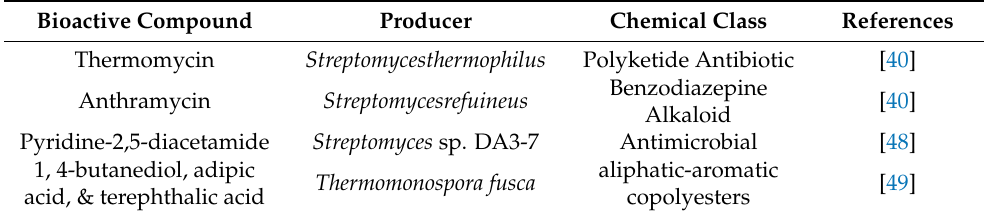
Table 2. List of bioactive compounds from thermophilic, alkaliphilic and haloalkaliphilic Actinobacteria. Bioactive